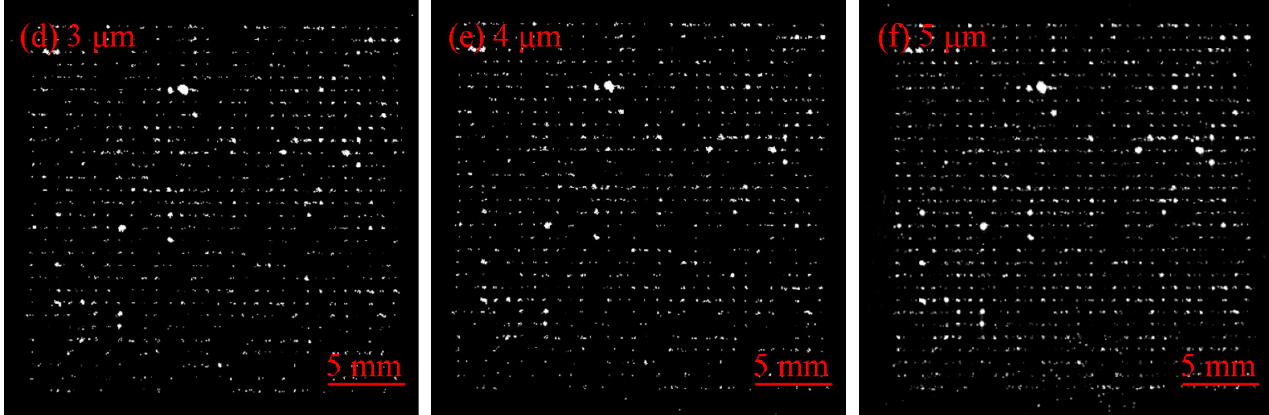
Figure 1. Dark field images of damage at different repair depths: ( a ) initial; ( b ) repair depth is 1 μ m; ( c ) repair depth is 2 μ m; ( d ) repair depth is 3 μ m; ( e ) repair depth is 4 μ m; ( f ) repair depth is 5 μ m.